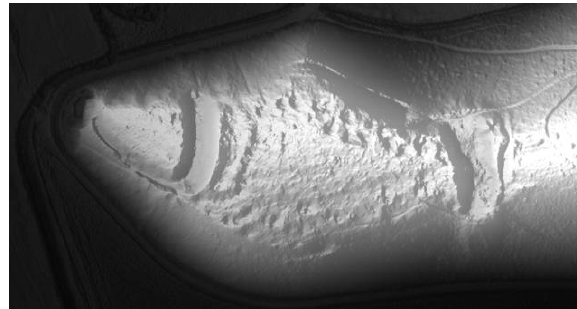
Figure 5. Radkov – profiles of GPR survey,